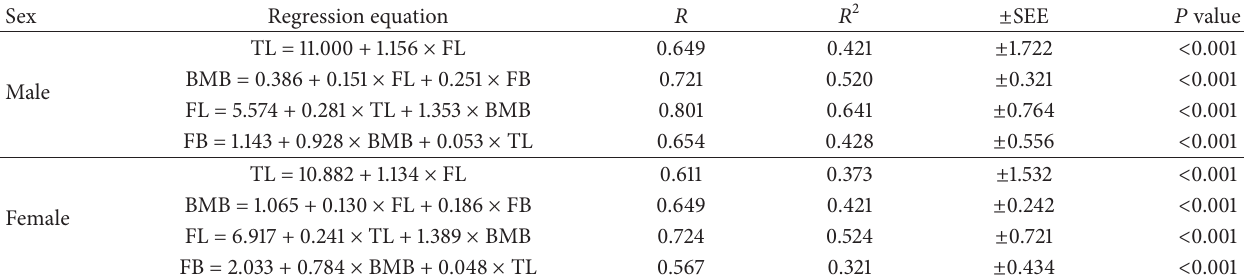
Table 5: Stepwise regression equations for reconstruction of lower limb dimensions (in cm).